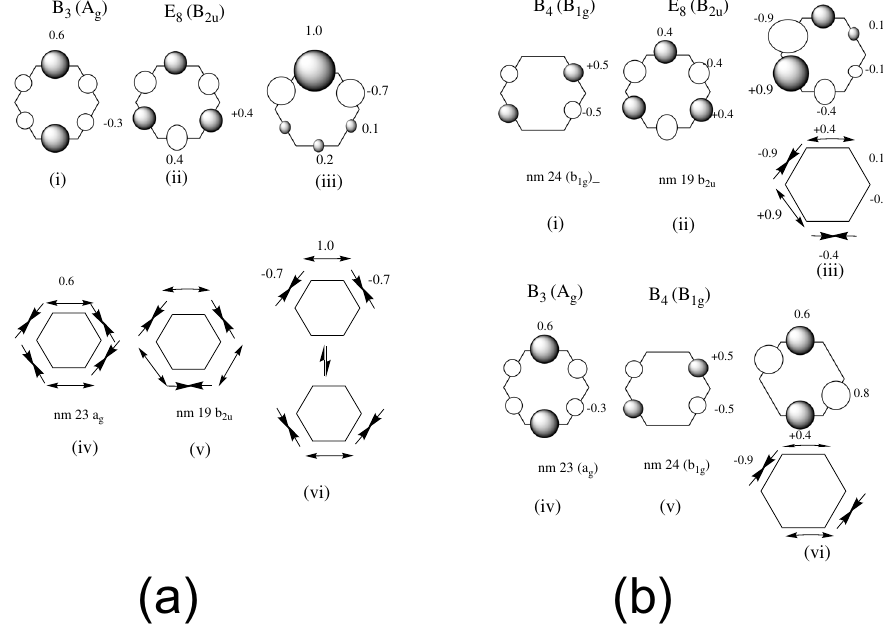
Fig. 3 Examples of superpositions of electronic states and normal modes. a The superposition of a component of the B state (B 3 , part i) which is a component of the B state (with symmetry E 2 g in D 6 h and A g in D 2 h ), mixed with E 8 (part ii) (with symmetry B 2 u ) and a similar relation for nm 23 (part iv), and nm 19 (part v). b As for a , but mixing B 4 E 8 (parts i and ii) and B 3 B 4 (parts iv and